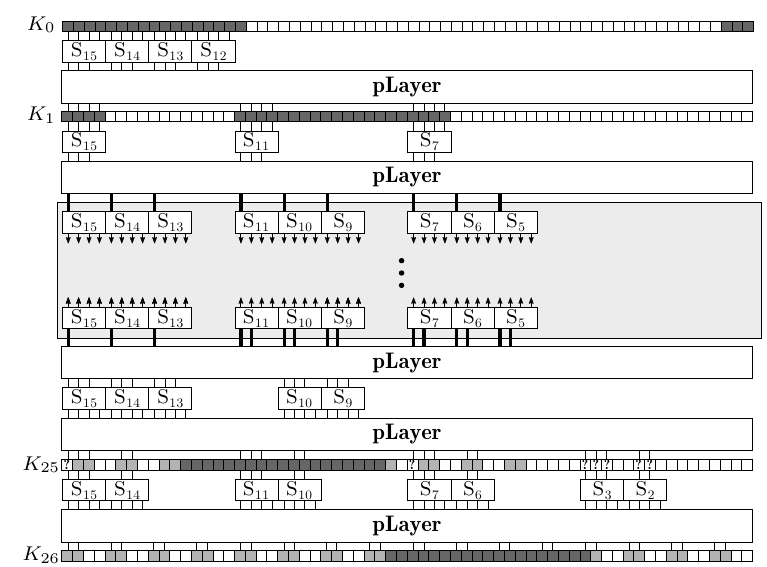
Figure 4: An outline of the 26-round attack using 22 round approximations. The in- put/output mask bits are indicated by bold lines. The dark grey squares indicate the round key bits obtained by guessing 24 bits of the master key. The light grey squares indicate the round key bits obtained by guessing 23 bits of the last round key. The squares indicated by ? are extra bits of the second to last round key that need to be